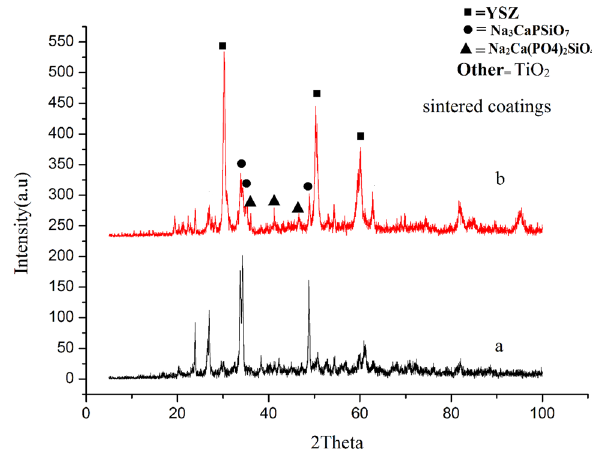
Fig. 5 XRD pattern of green coating of bioactive glass and bioac- tive glass-YSZ composites